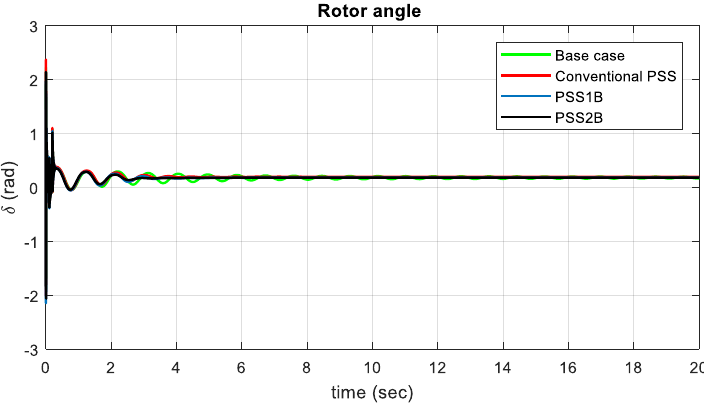
Figure 19. Generator rotor angle of the power system at heavy loading.